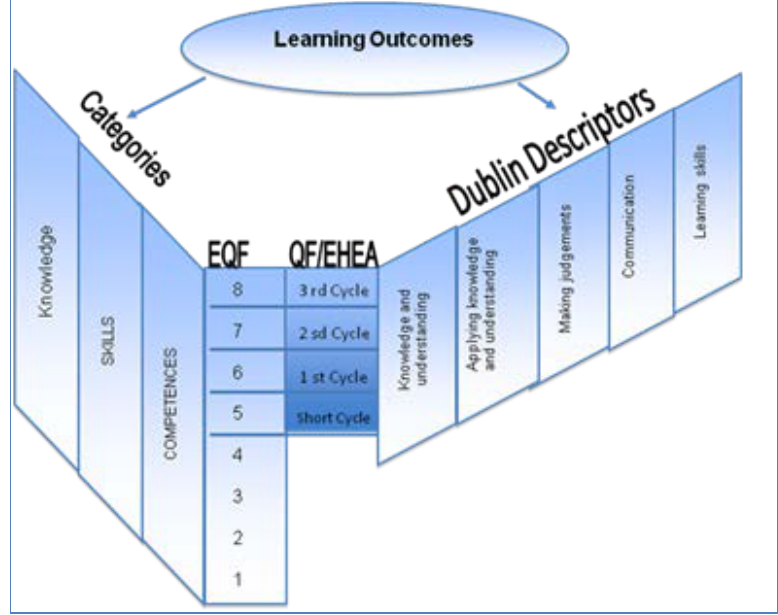
Figure 1. Benchmarking between Qualifications Framework for the European Higher Education Area (QF/EHEA) and European Qualifications Framework for Lifelong Learning (EQF) (Lourtie,